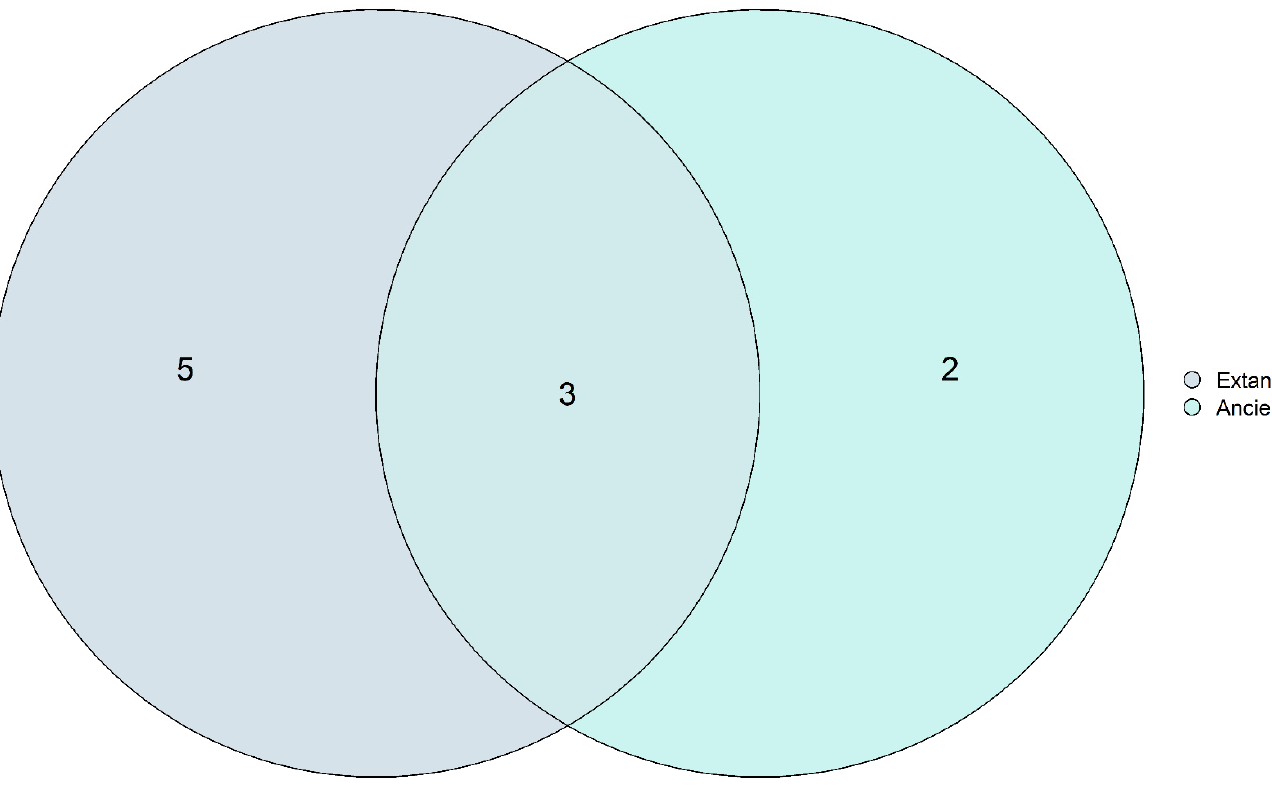
Figure 8. Core mycobiome. Total fungal genera detected with >0.1% relative abundance in at least 90% of the samples.